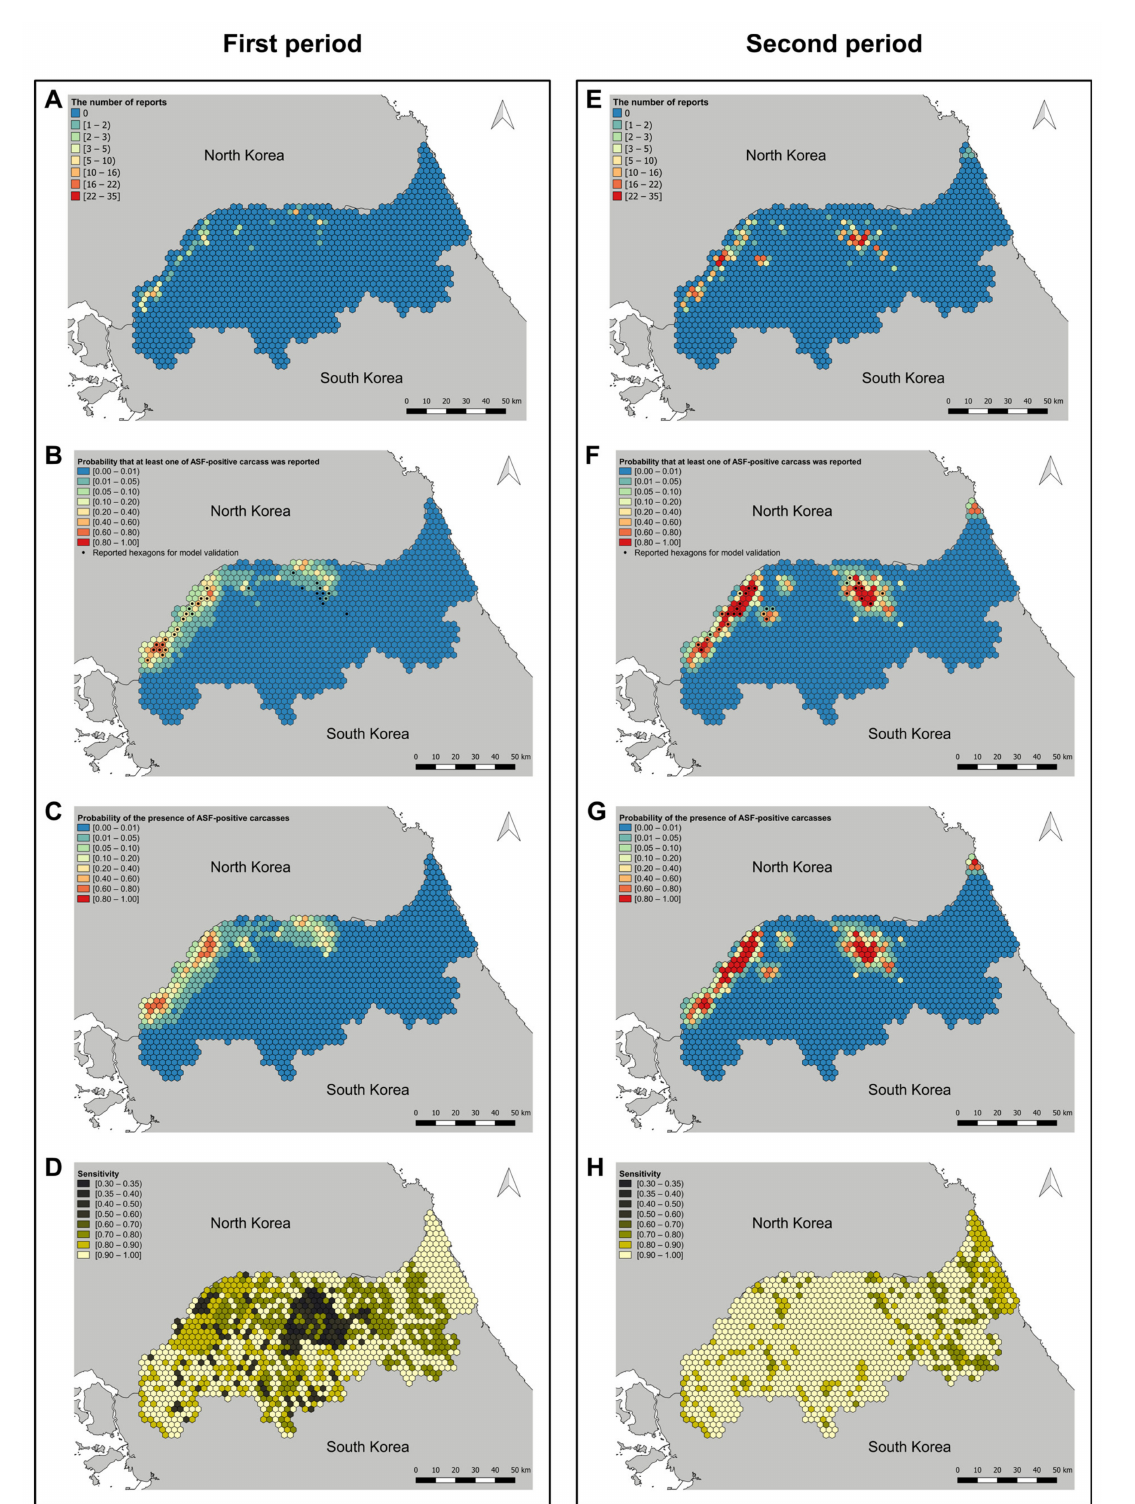
Figure 3. Choropleth maps of the number of reports of African swine fever (ASF) – positive wild boar carcasses (( A , E ) for each period), the median value of the probability that at least one report of ASF-positive wild boar carcass (( B , F ) for each period), the median value of the probability of presence of ASF-positive wild boar carcasses (( C , G ) for each period), and the median value of the sensitivity (( D , H ) for each period) for the first and second periods. These maps were plotted using QGIS version 3.4.11. http://qgis.osgeo.org (accessed on 10 March